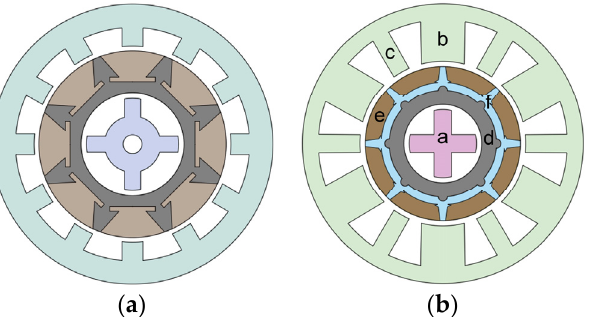
Figure 21. ( a ) is a 12/8 BSRM with segmental rotors and FP winding; ( b ) is a 12/8 BSRM with segmental rotors and ST winding where “a” is inner stator, “b” and “c” are the excited pole and auxiliary pole of the outer stator, respectively, “d” is toroidal iron core, “e” is the rotor segment, and “f” is the non-magnetic isolator.